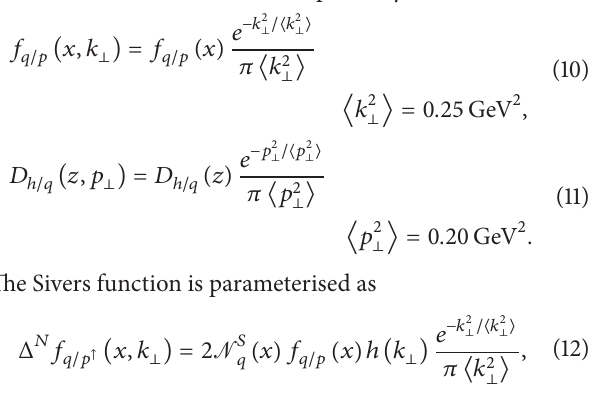
and 𝜋 0 production in 𝑝𝑝 ↑ → 𝜋𝑋 processes, computed according to (6)–(8) of the text. The contributions from the Sivers and the Collins effects are added together. The computation is performed adopting the Sivers and Collins functions of [20, 22] (SIDIS 1-KRE, left panels) and of [21, 23] (SIDIS 2-DSS, right panels). The overall statistical uncertainty band, also shown, is the envelope of the two independent statistical uncertainty bands obtained following the procedure described in Appendix A of